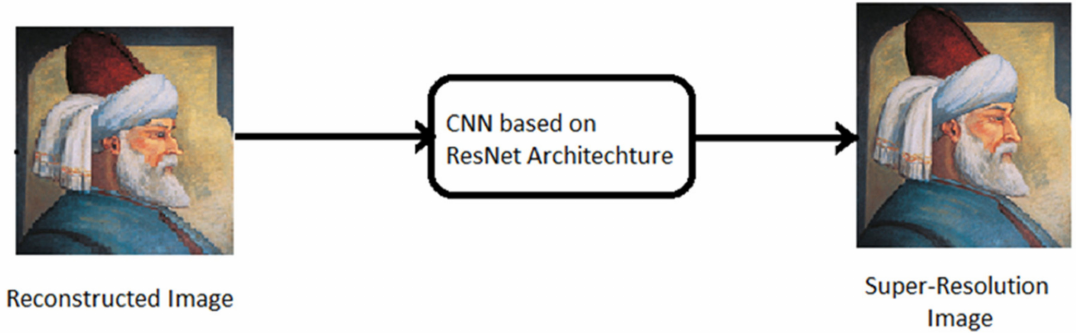
Figure 3. Input and Output of ResNet based